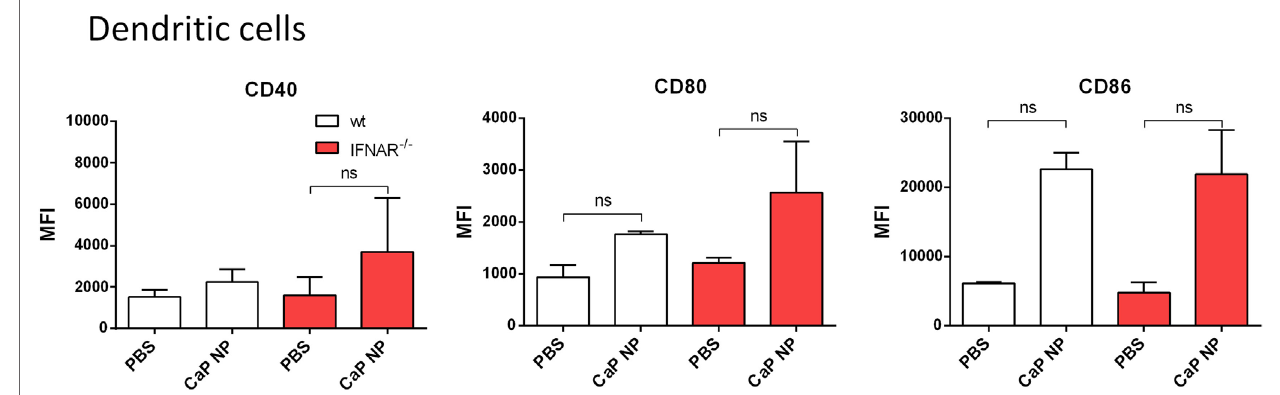
FigUre 2 | Activation of dendritic cells is independent of type I interferon (IFN I) signaling after vaccination with functionalized calcium phosphate (CaP) nanoparticles (NPs). C57BL/6 mice or IFNAR − / − mice were vaccinated subcutaneously either with phosphate- buffered saline (PBS) or CpG and FV peptide functionalized CaP NPs. 6 h postvaccination, mice were sacrificed and CD11c high cells from the popliteal lymph node were stained for CD40 and expression of costimulatory molecules CD80 and CD86. The results of two independent experiments are depicted, n = 6. Data represent mean ±